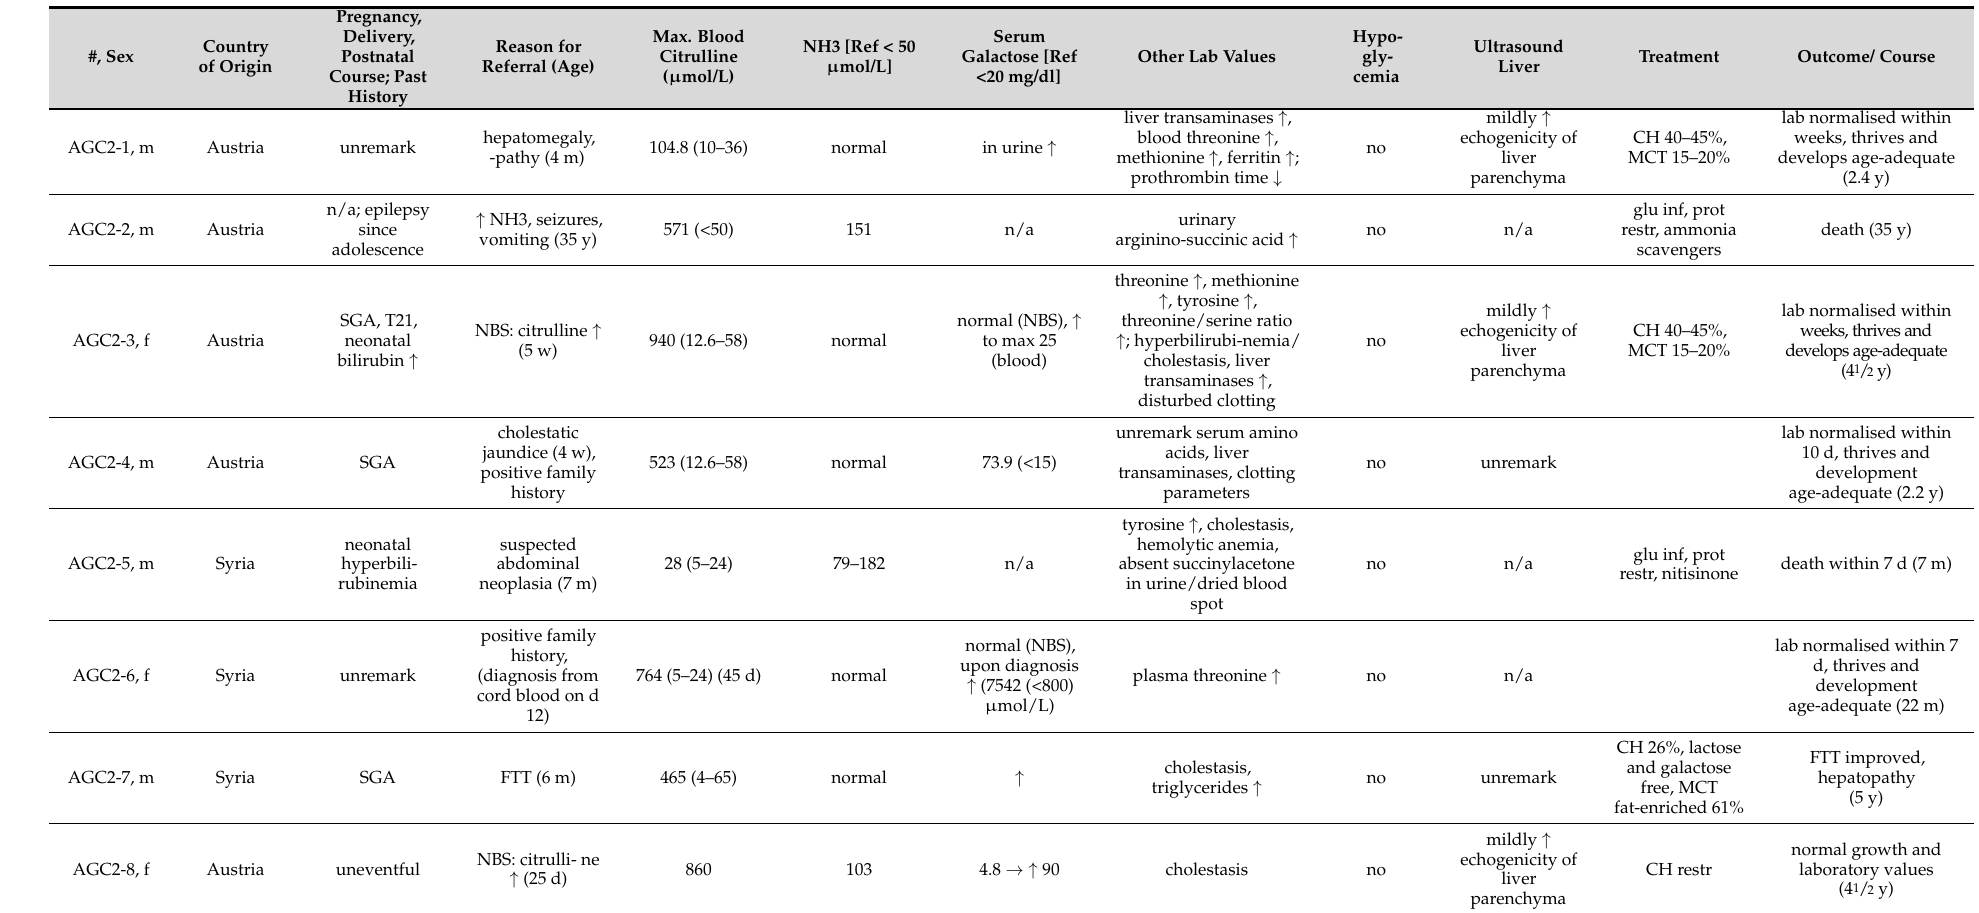
Abbreviations in Table 2: d = day(s), w = week(s), m = month(s), y = year(s), n/a = not available, unremark = unremarkable, SGA = small for gestational age, CH = carbohydrates, MCT = medium chain triglycerides, glu = glucose, prot = protein, inf = infusion, restr = restriction, NBS = new born screening, ↑ =